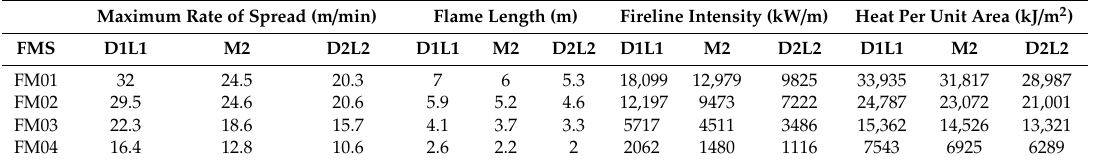
Table A3. Fire behavior simulation results using the BehavePlus software for the four custom fuel models for conifer forests. FMS: Fuel Moisture Scenario. Maximum Rate of Spread (m / min) Flame Length (m) Fireline Intensity (kW / m) Heat Per Unit Area (kJ / m 2 )